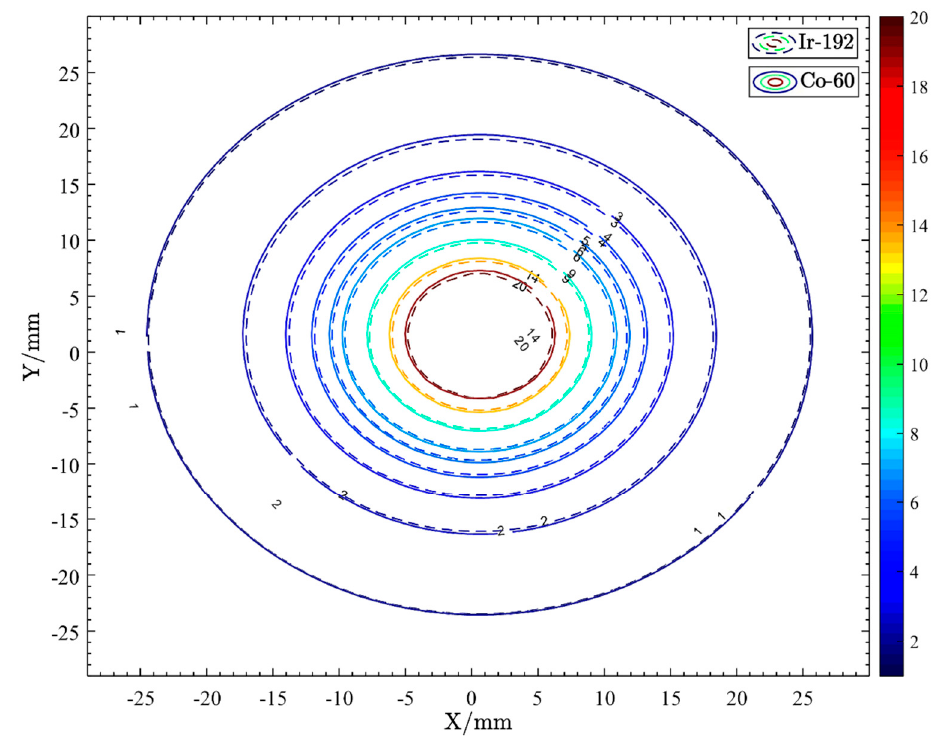
Figure 3. Isodose line of single points of 192Ir and 60Co.